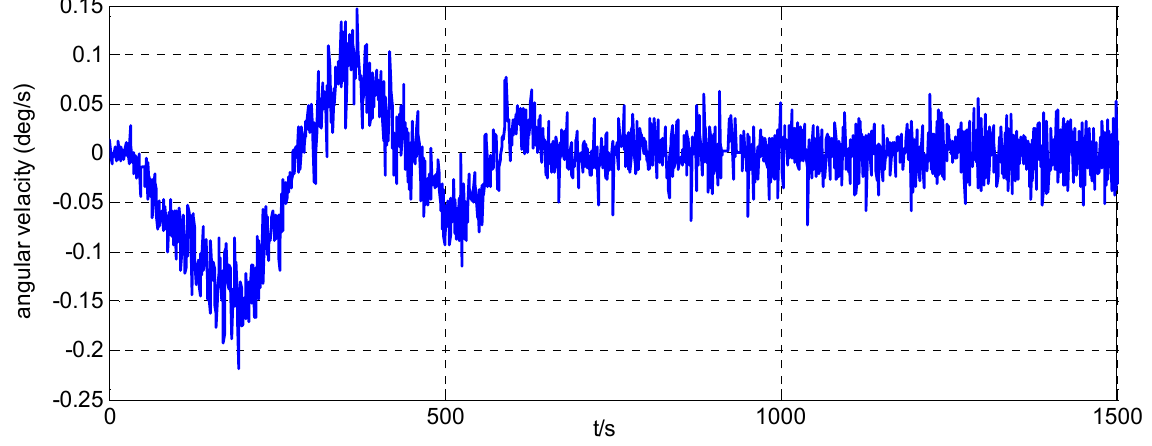
Figure 11. Angular velocity around the z-axis of the simulator when θ z ( 0 ) = 1.7 ◦ .